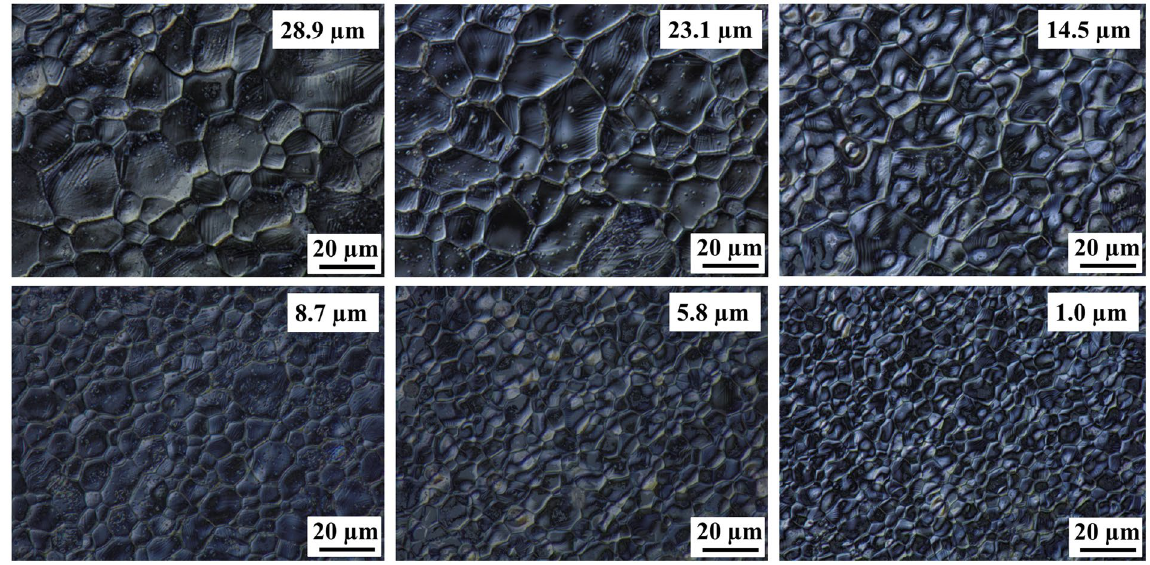
Figure 12. Surface micrographs of the alloys Ni 0.500 Mn 0.419 Sn 0.081 , with decreasing thicknesses under optical microscope.